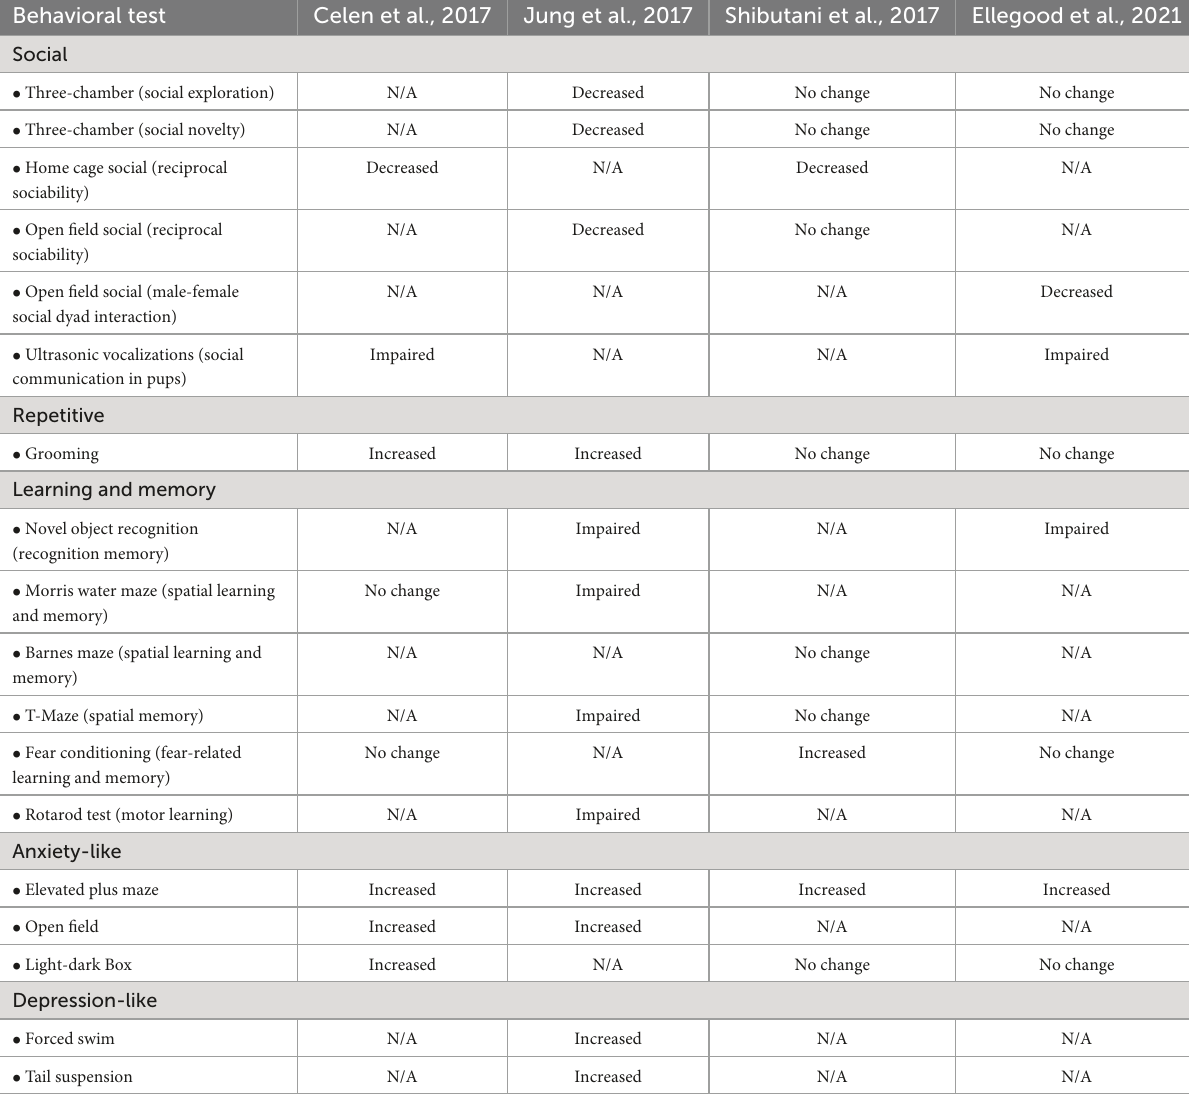
TABLE 1 Comparison of behavioral phenotypes observed in AT-Rich Interactive Domain 1B (Arid1b) mouse lines. Behavioral